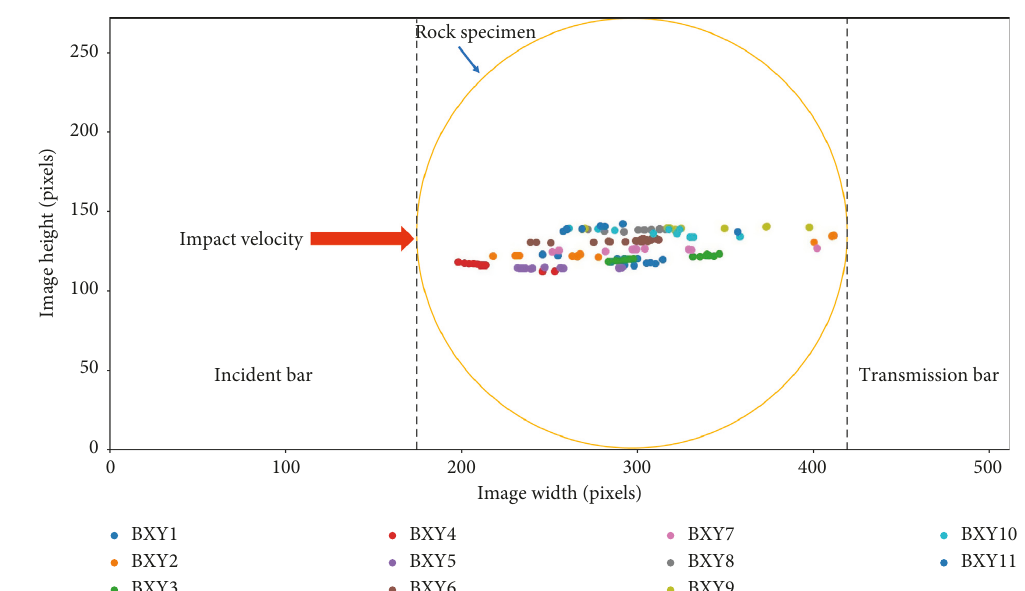
and V D ; (b) relationship between V Comp